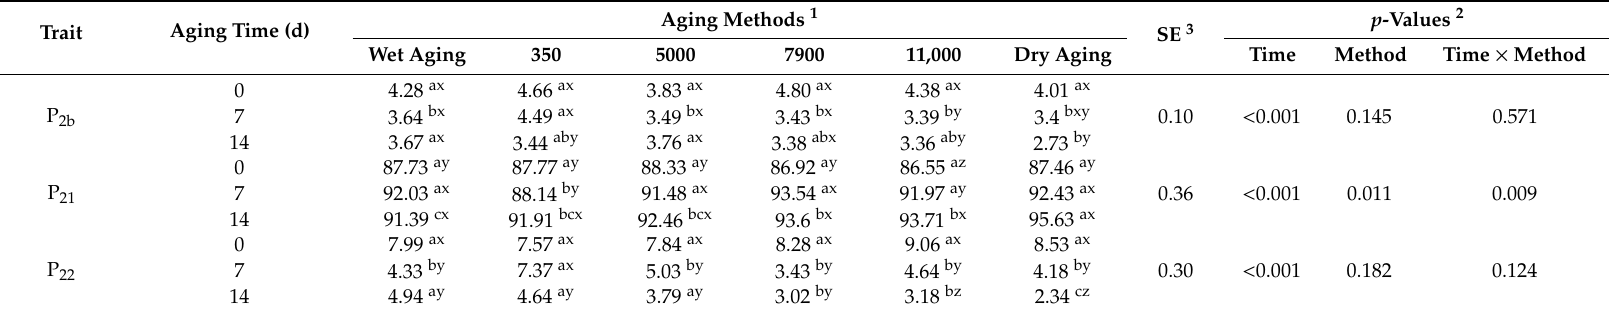
Table 6. E ff ects of di ff erent aging methods and di ff erent aging time on the moisture distribution of